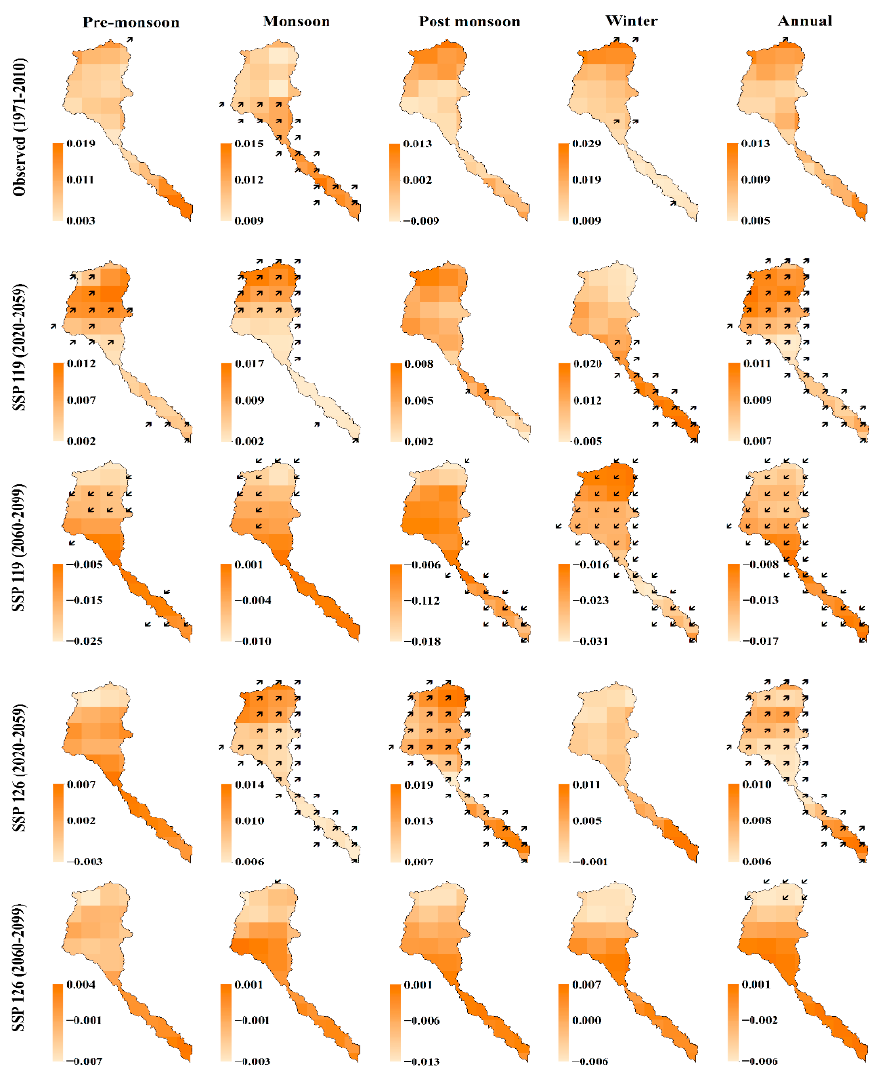
Figure 3. Spatial distribution of trend (significant at 95% confidence level) and magnitude in the seasonal and annual series of T max during the observational and future period (tilted upward arrow denotes significant increasing trend and vice versa).